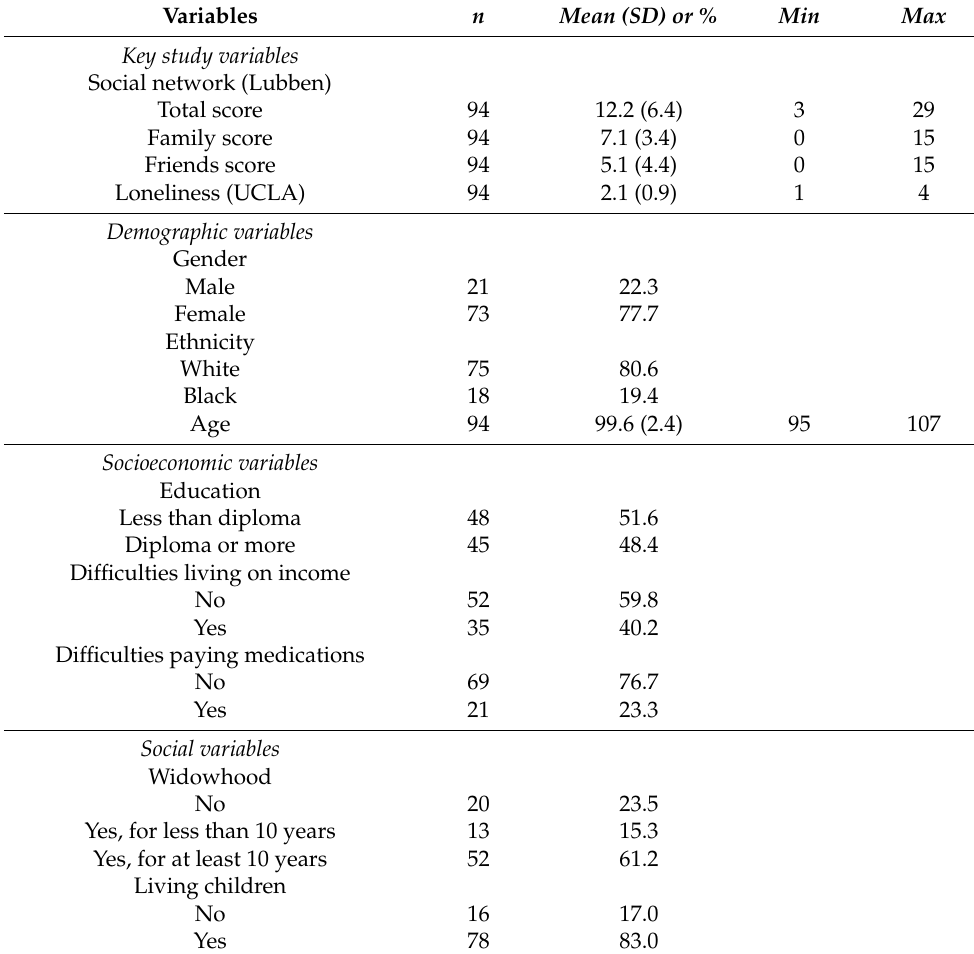
Table 1. Characteristics of Study